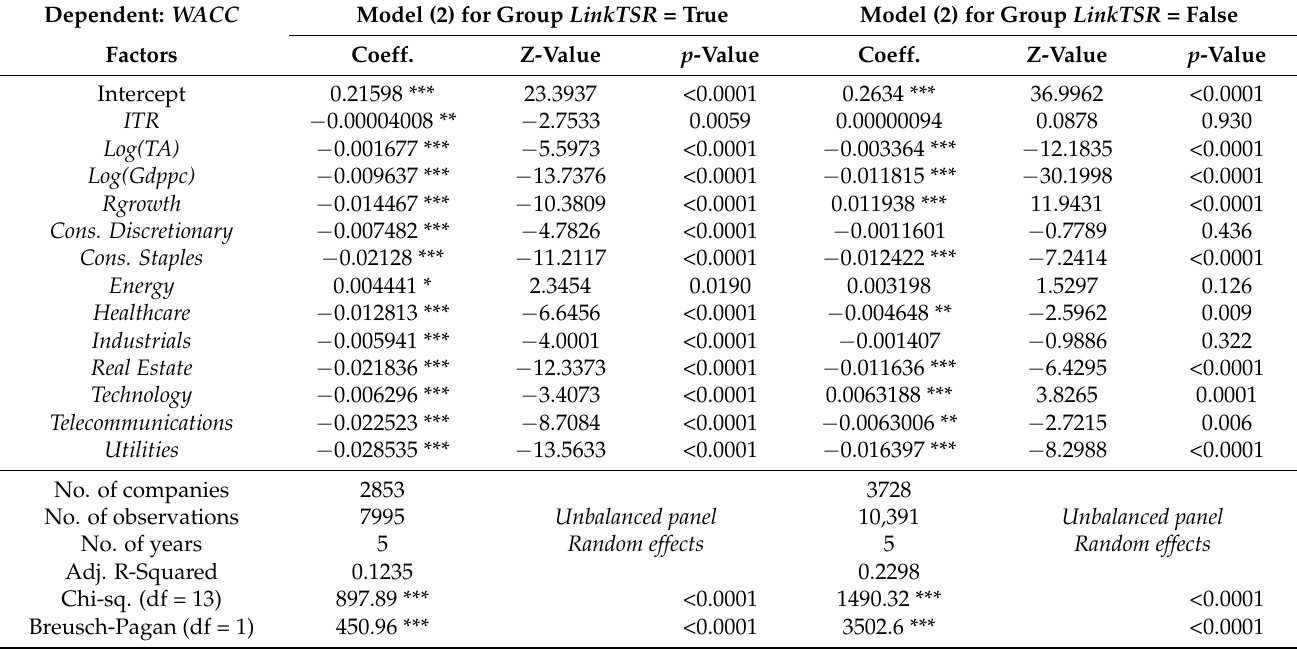
Table 14. Panel regression results for the weighted average cost of capital ( WACC) as the dependent variable, with sample companies grouped by LinkTSR